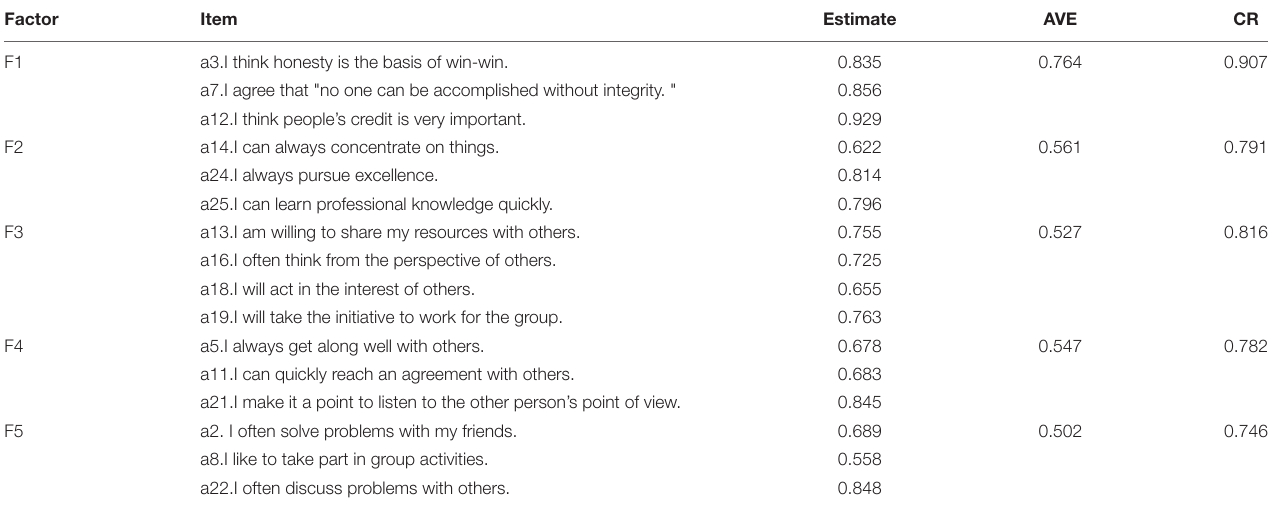
TABLE 4 | The convergent validity of win-win. Factor Item